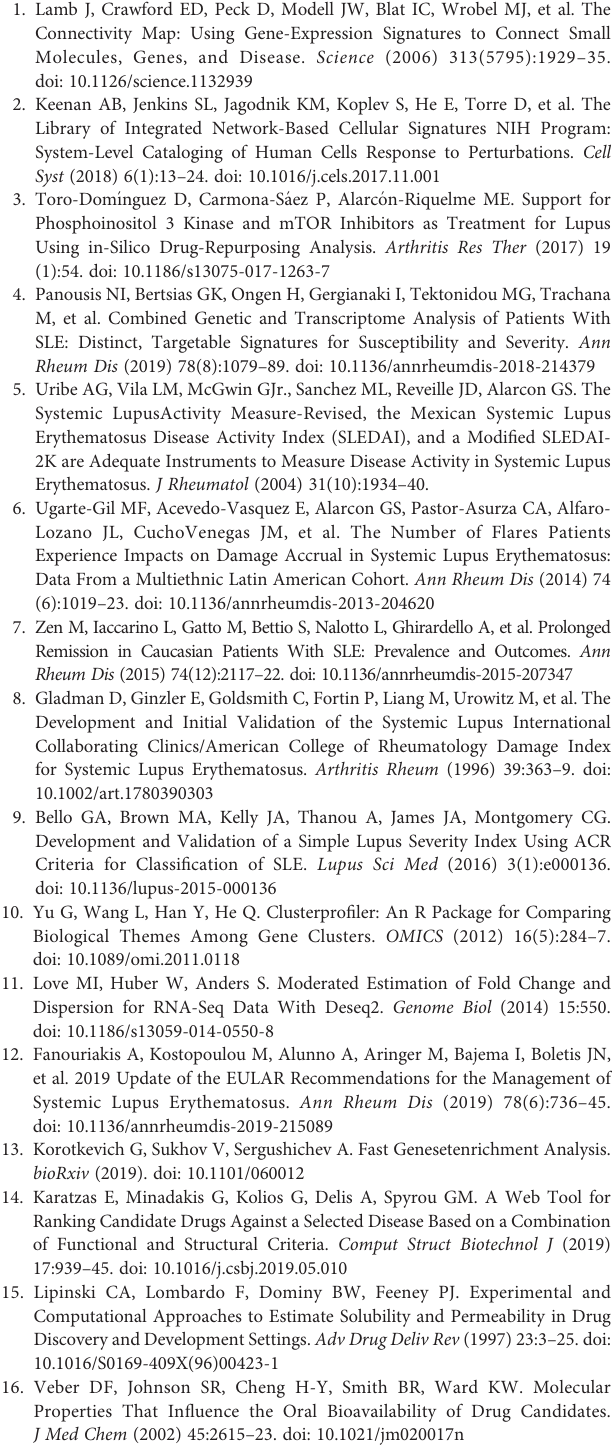
Supplementary Table 15 | Ranking of the compounds derived from the CLUE platform, through the CoDReS platform. This analysis was performed for SLE patients ’ molecular endotypes